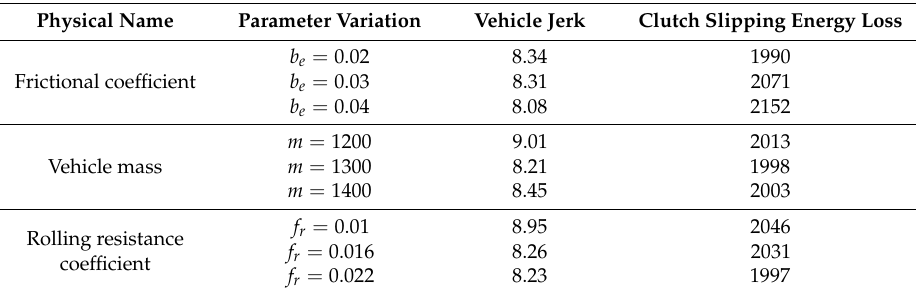
Figure 10. Comparison result for adaptability analysis. ( a ) Vehicle jerk under different engine frictional coefficients, ( b ) clutch slipping energy loss under different engine frictional coefficients, ( c ) vehicle jerk under different vehicle mass, ( d ) clutch slipping energy loss under different vehicle mass, ( e ) vehicle jerk under different rolling resistance coefficient, ( f ) clutch slipping energy loss under different rolling resistance coefficient. Table 4. Summary of comparison results for different parameter variations.